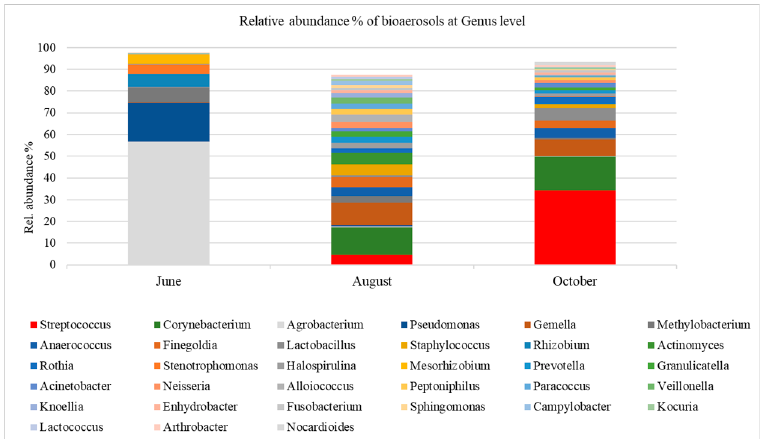
Figure 3. The relative abundance % of bacterial aerosols at the genus level in the urban air of